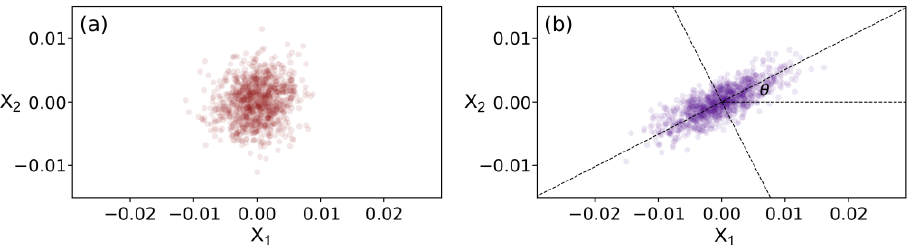
Figure 2. Clouds in single-mode phase space corresponding to coherent-state noise ( a ) and the squeezed quantum noise ( b ). X 1 and X 2 are two conjugate quadratures of the electromagnetic field (with their mean values subtracted) of the considered single mode. Each point in the cloud corresponds to a particular realization of the quantum trajectory in the phase space obtained by the modeling; the scattering of the points around the mean values represents the quantum uncertainty.